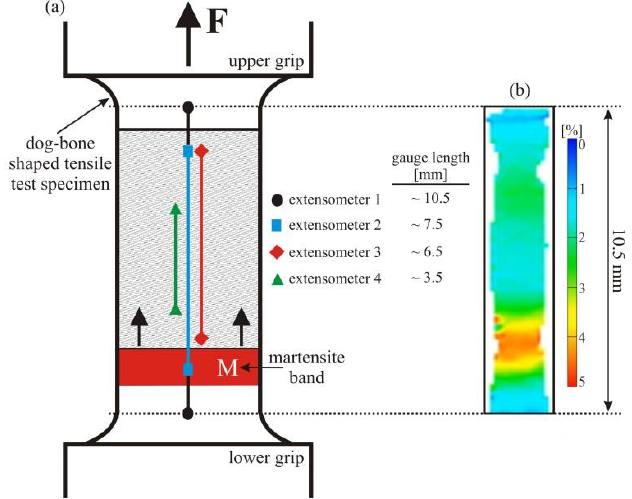
Figure 2. ( a ) Schematic representation of the dog-bone-shaped tensile test specimen with four virtual extensometers used for investigation of the effect of the extensometer position, with respect to the nucleation side of the martensite band; ( b ) axial surface strain field image measured at a macroscopic strain of about 2.1%. The analyzed extensometers are shifted sideways from the center line (where they were located in the actual analysis of DIC data) to provide a better overview.